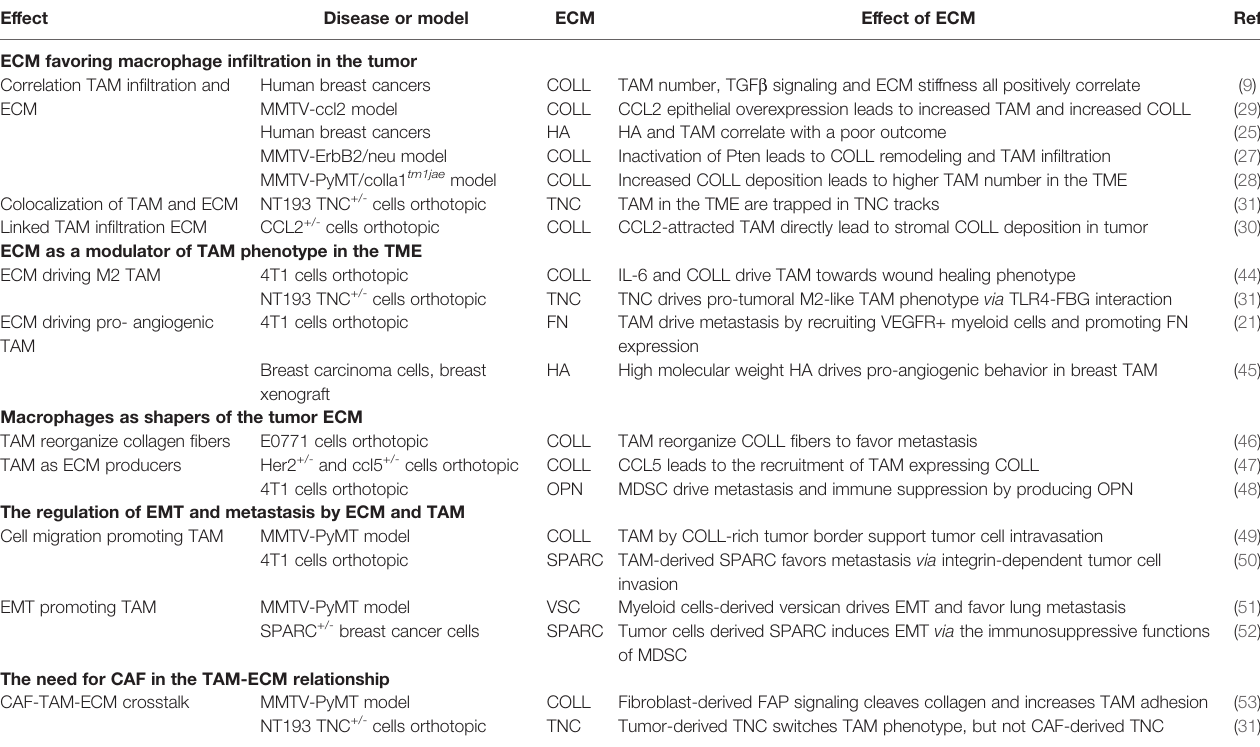
TABLE 1 | TAM and ECM interactions described in breast cancer